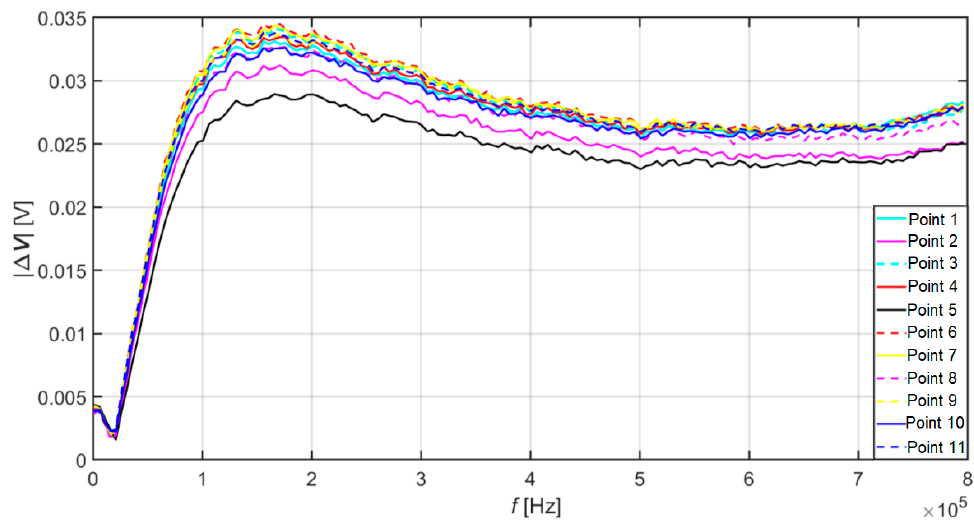
Figure 10. Graph of the absolute value of the voltage phasor of Specimen 6 corrosion crack.